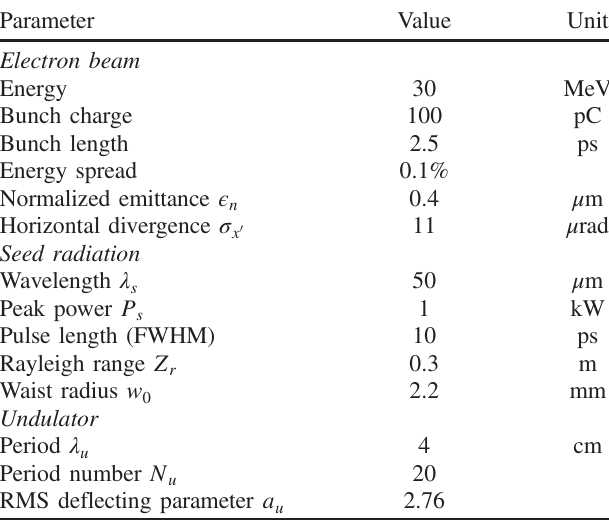
TABLE I. Main electron beam and energy modulator parameters.